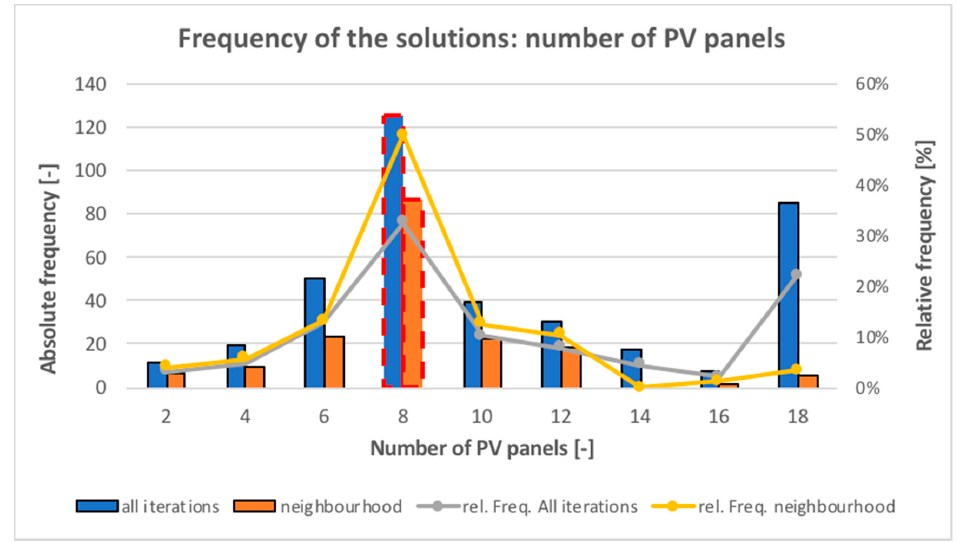
Figure 12. Robustness profile: number of PV panels, financial objective, sequential optimization.